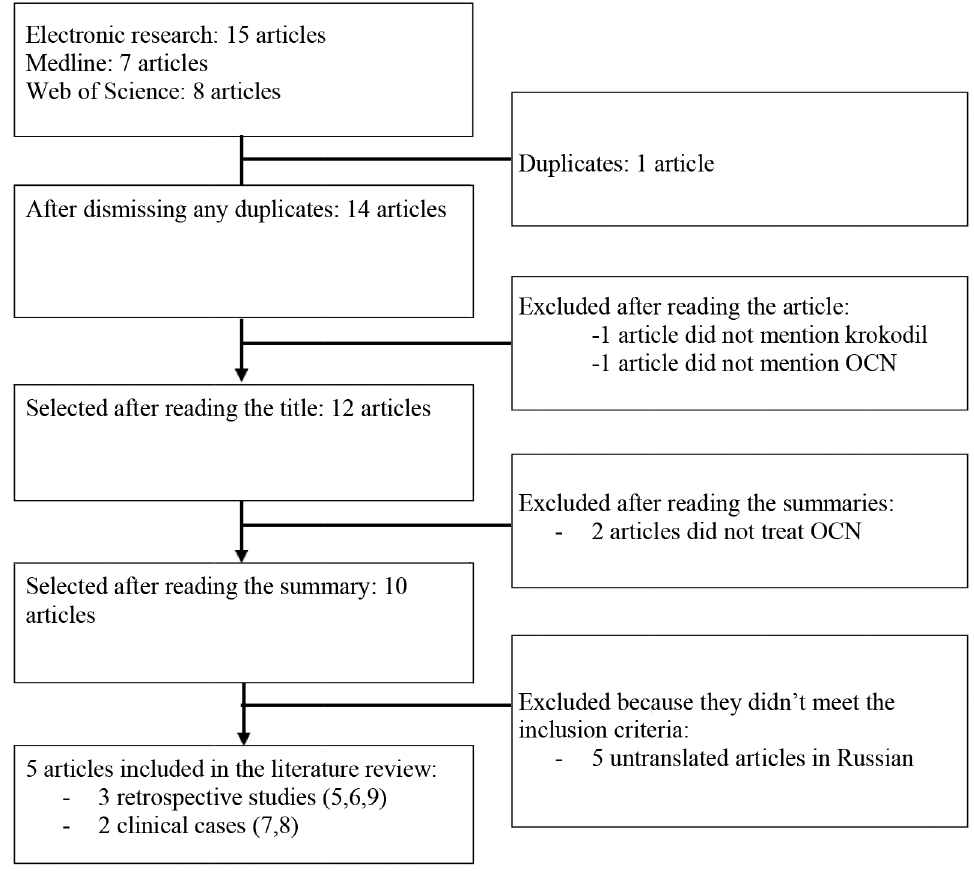
Fig. 1. Flow chart of